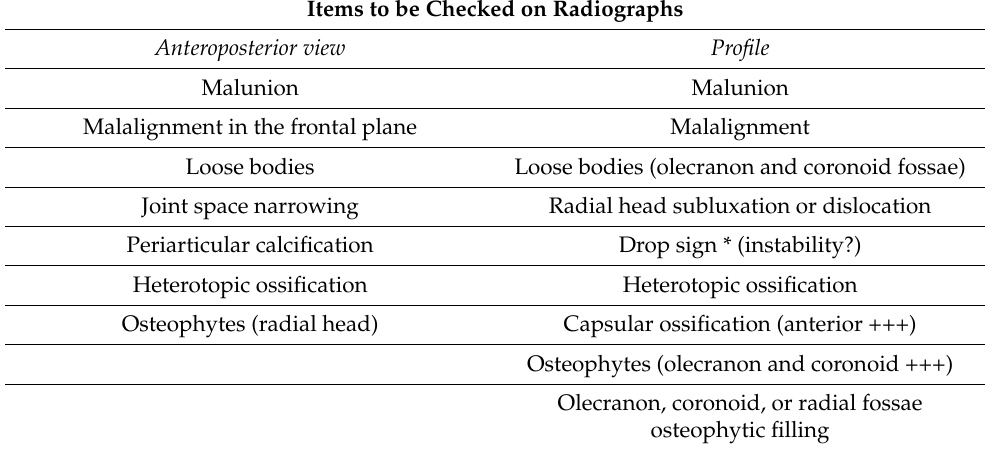
Table 2. Radiographic